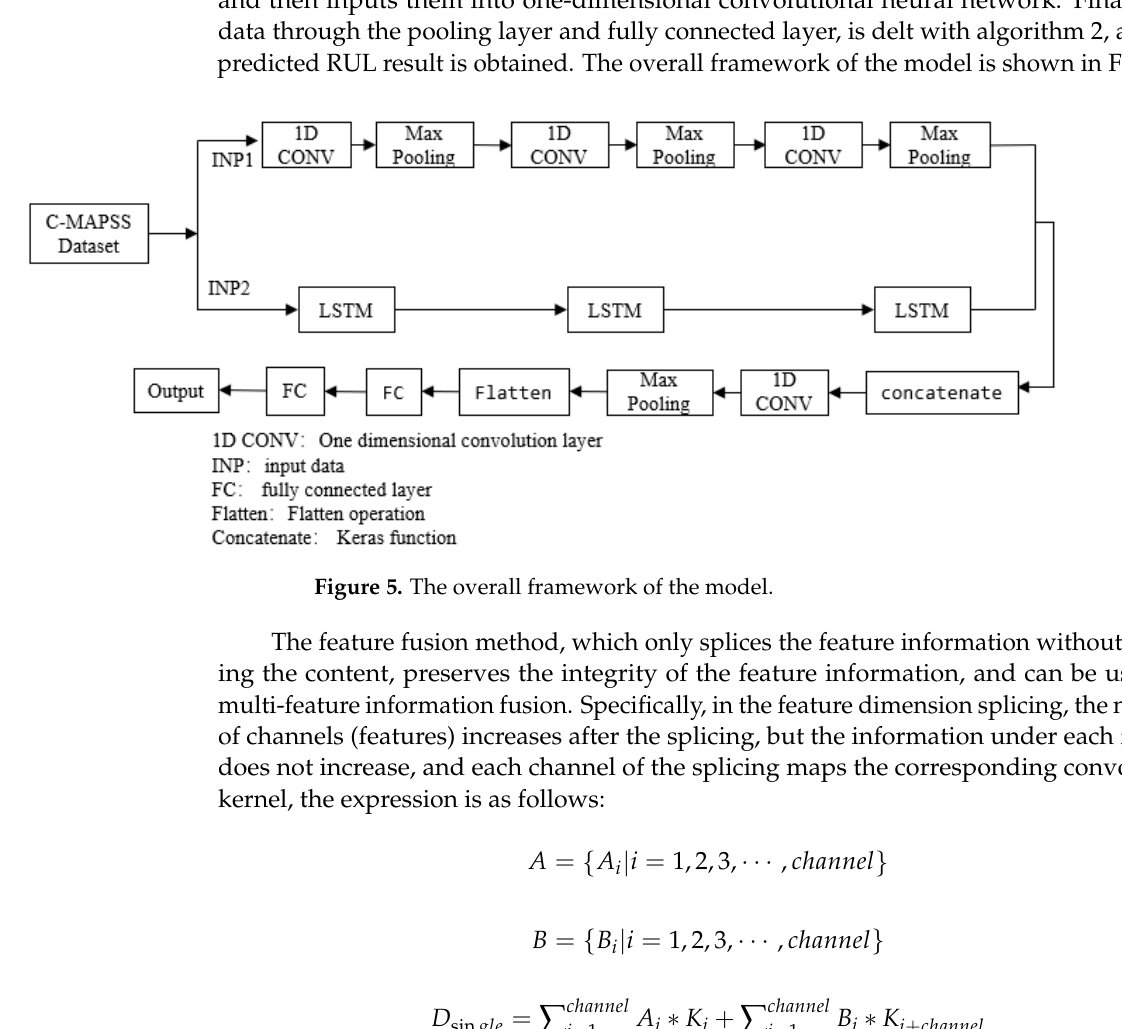
7 of 21 Figure 4. The curve of root mean square error (RMSE) and scoring function (SF). 3. 1-FCLCNN-LSTM Prediction Mode 3.1. Overall Frameworks The life prediction model 1-FCLCNN-LSTM proposed in this paper adopts the idea